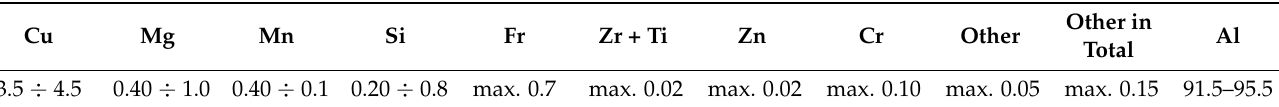
Table 1. Composition of alloying elements of the workpiece material, %.